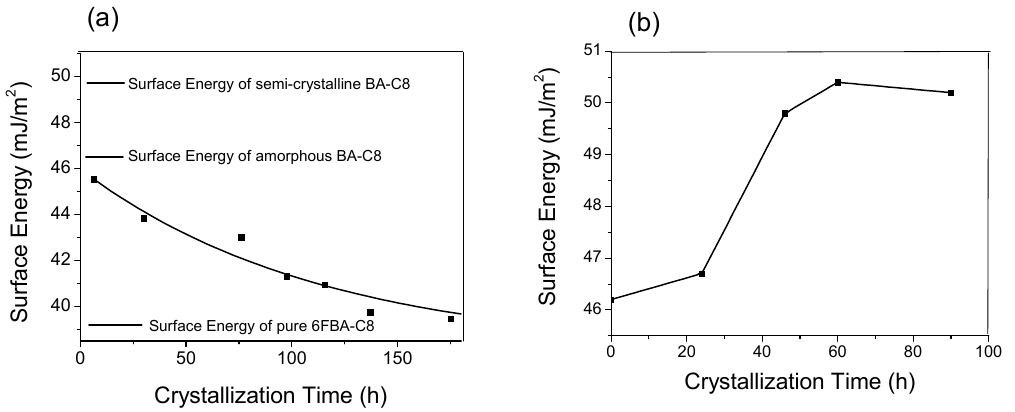
Figure 4. ( a ) Plot of the surface energy of the BA-C8/6FBA-C8 (80/20) blend as a function of crystallization time ( b ) plot of the surface energy of BA-C8 as a function of crystallization time